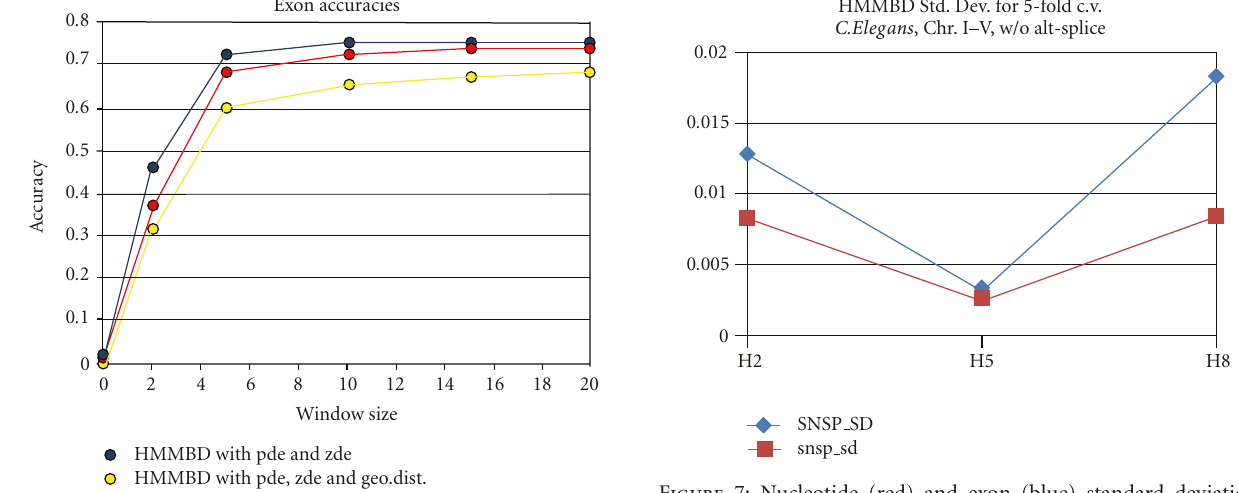
Figure 7: Nucleotide (red) and exon (blue) standard deviation results for Markov models of order: 2, 5, and 8, using the 5-bin HMMBD (where the standard deviation of the AC values of the five folds is